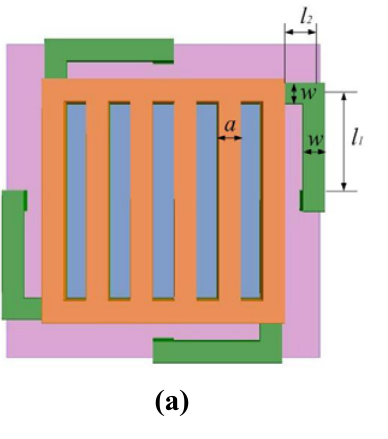
Figure 7. The structure and the parameters of the GLM. ( a) The top image; (b) The cross- section